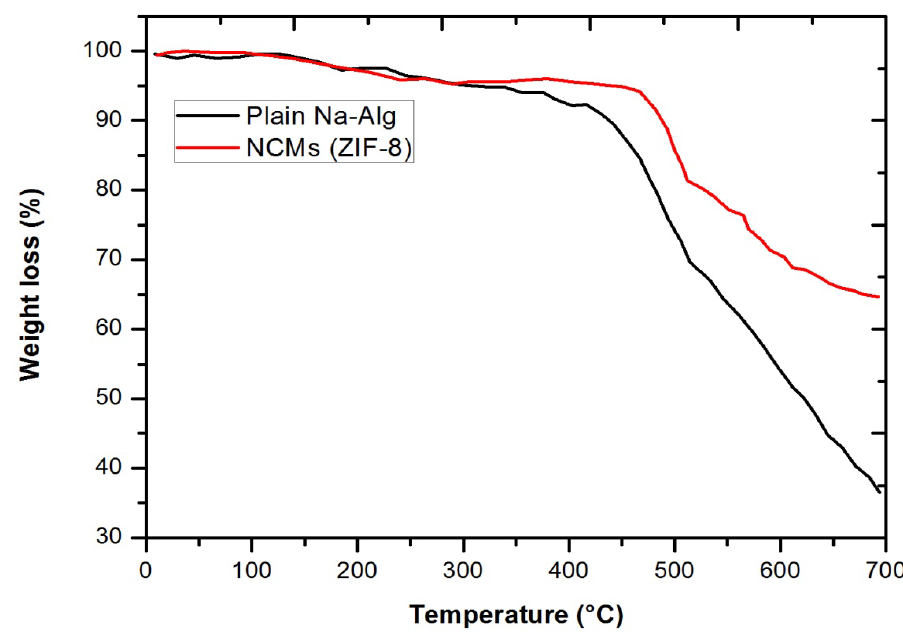
Figure 9. TGA curves of plain Na-Alg and NCMs (ZIF-8).